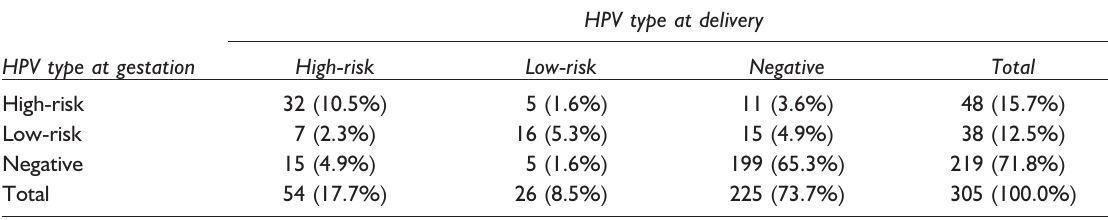
HPV type at delivery